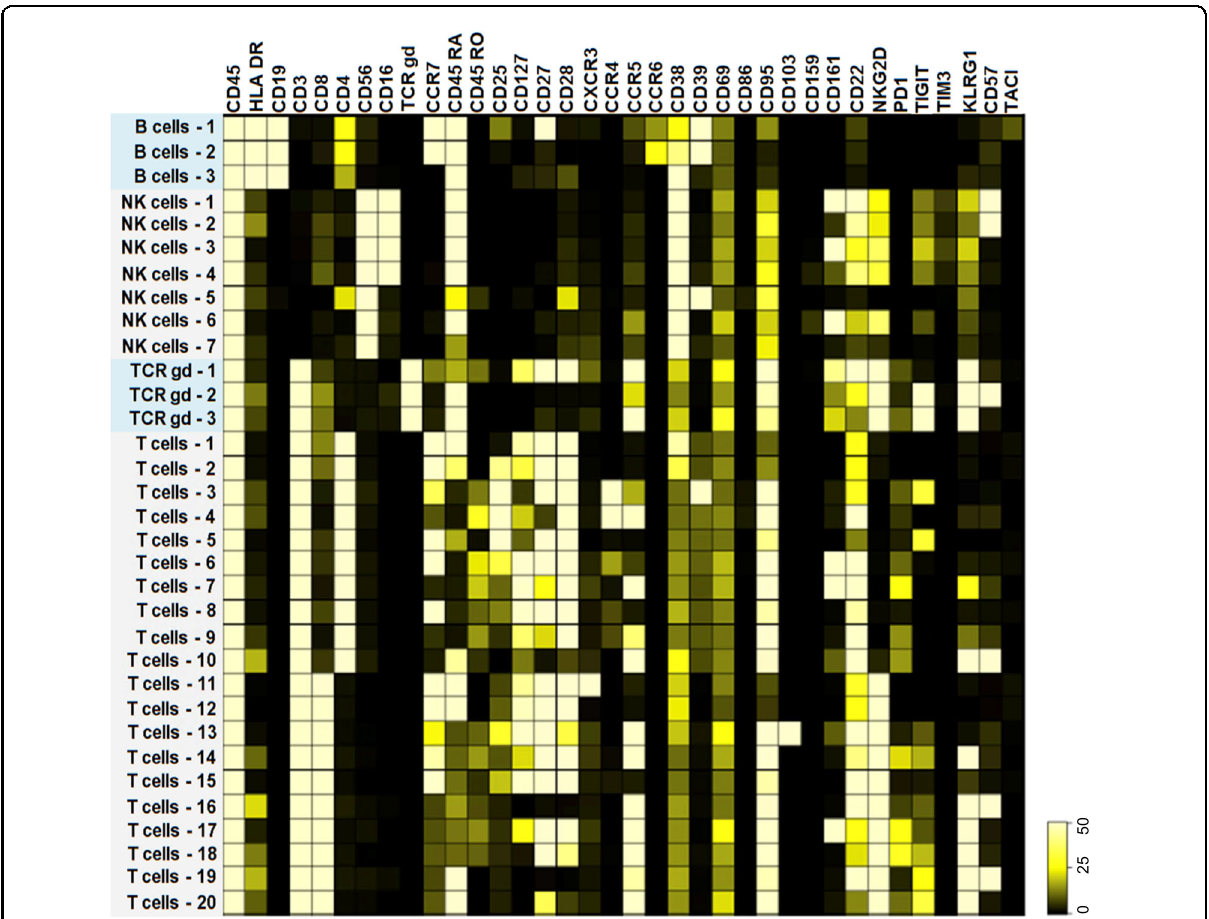
Fig. 2 Immune phenotype of cellular subsets. The heat map highlights the marker expression within each unique cellular subset identi fi ed by mass